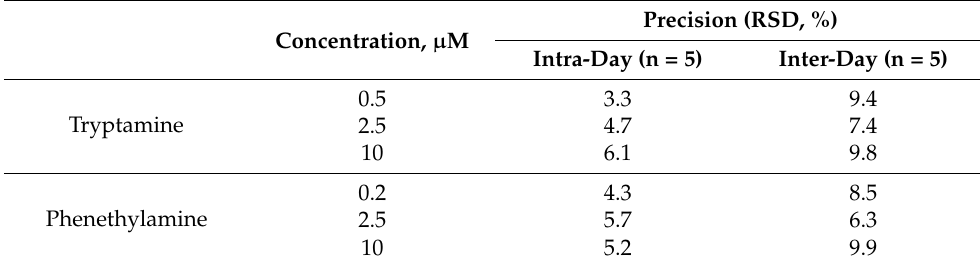
Table 3. The results of the reproducibility study of the proposed method. Concentration, µ